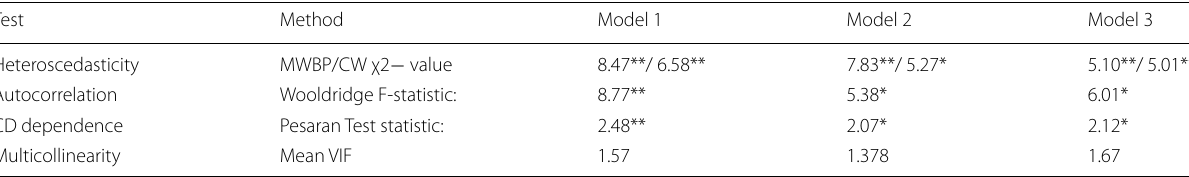
Table 5 Diagnostics test for ROE model